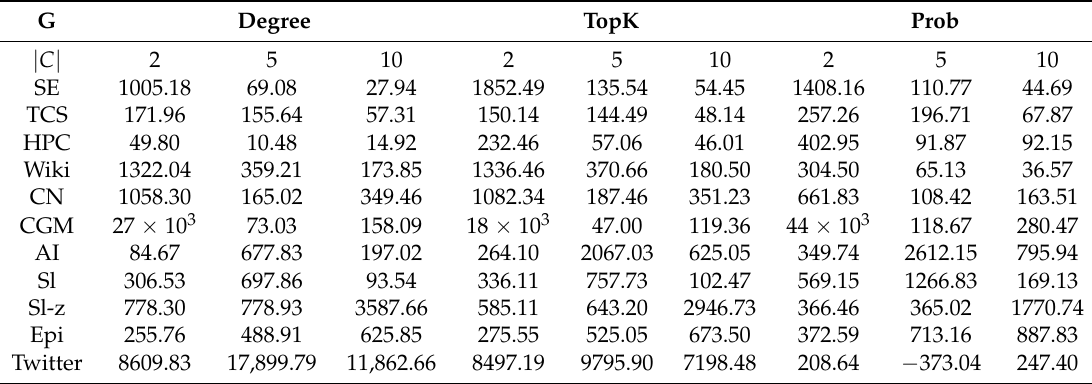
Table 4. Baseline results for real-world networks.